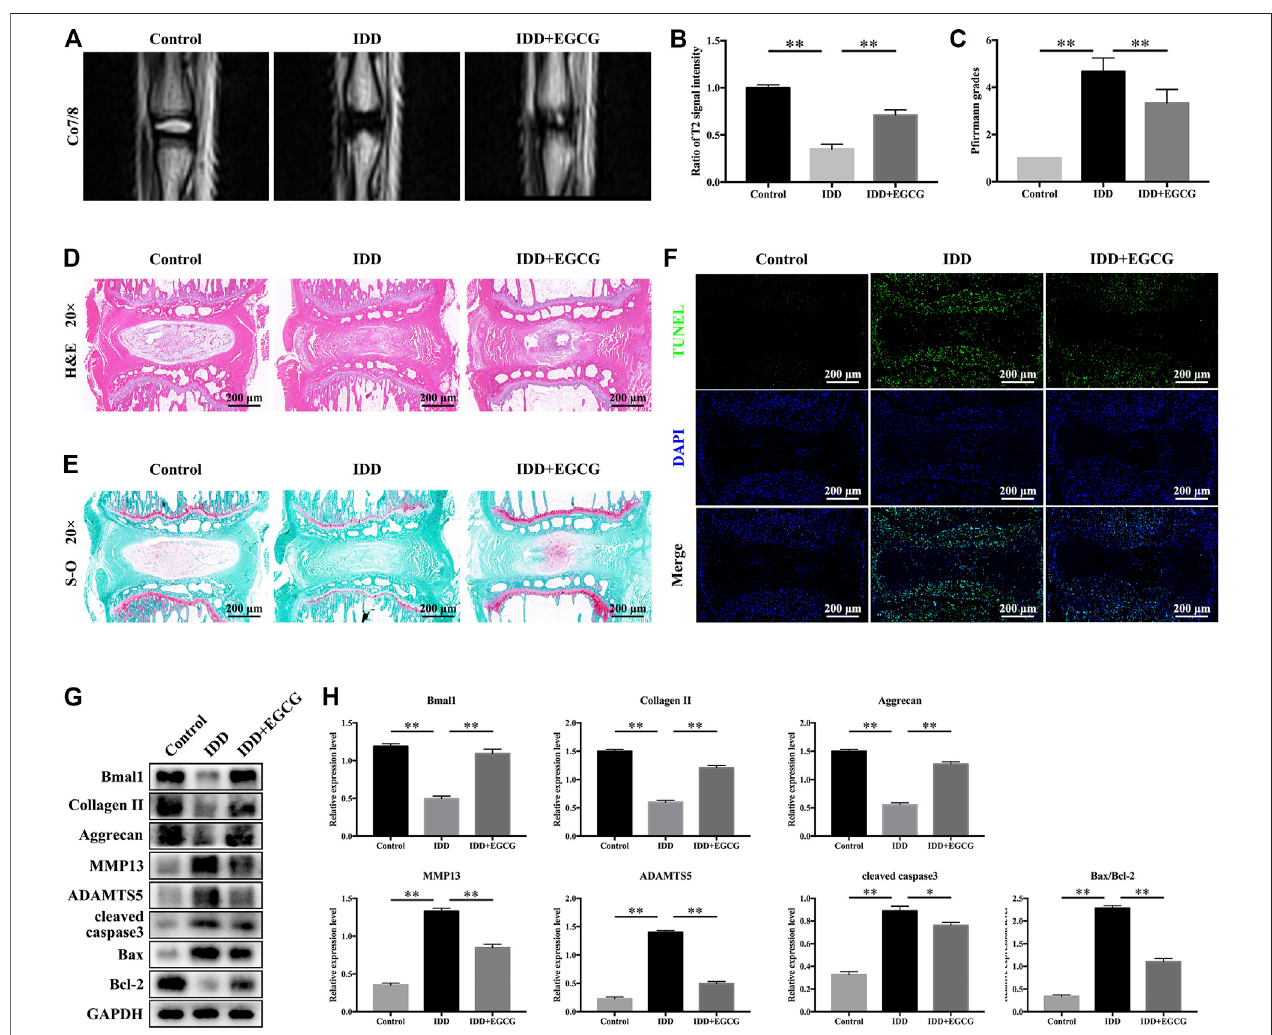
FIGURE 7 | EGCG alleviated IDD progression in a rat model by regulating the circadian clock. (A) T2-weighted MRI images of rat tails at 8 weeks after surgery. (B) QuantitativeanalysisoftheT2discsignalintensity. (C) P fi rrmannMRIgradesforthethreegroupsat8 weekspost-surgery. (D) RepresentativeHandEaswellas (E) S-O stainingofthepunctureddiscsfromthevariousgroupsat8weeksaftersurgery. (F) ATUNELassaywasperformedconductedtoassessapoptoticlevelsinNPsamples from discs in various groups. (G) Western blot assay was conducted, and (H) protein levels of Bmal1, Collagen II, Aggrecan, MMP13, ADAMTS5, cleaved caspase3 and Bax/Bcl-2 in the NP samples of rats are shown. Data are shown as mean ± SD ( n (cid:2) 12). * p < 0.05, ** p < 0.01.